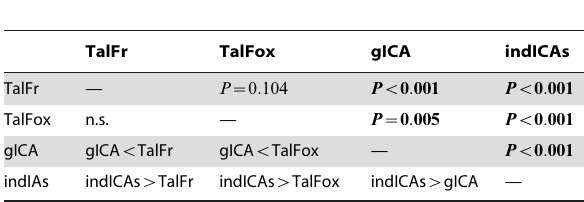
Table 5. Pairwise effects of method on interregional partial correlation.